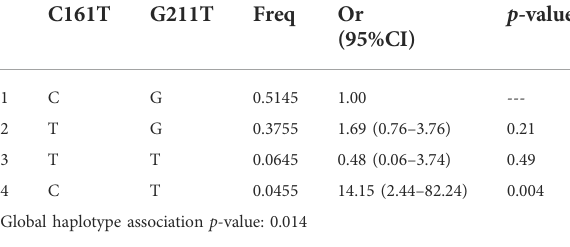
TABLE 7 Haplotype association of UGT2B7 C161T and G211T with response (n = 100, adjusted by Age +